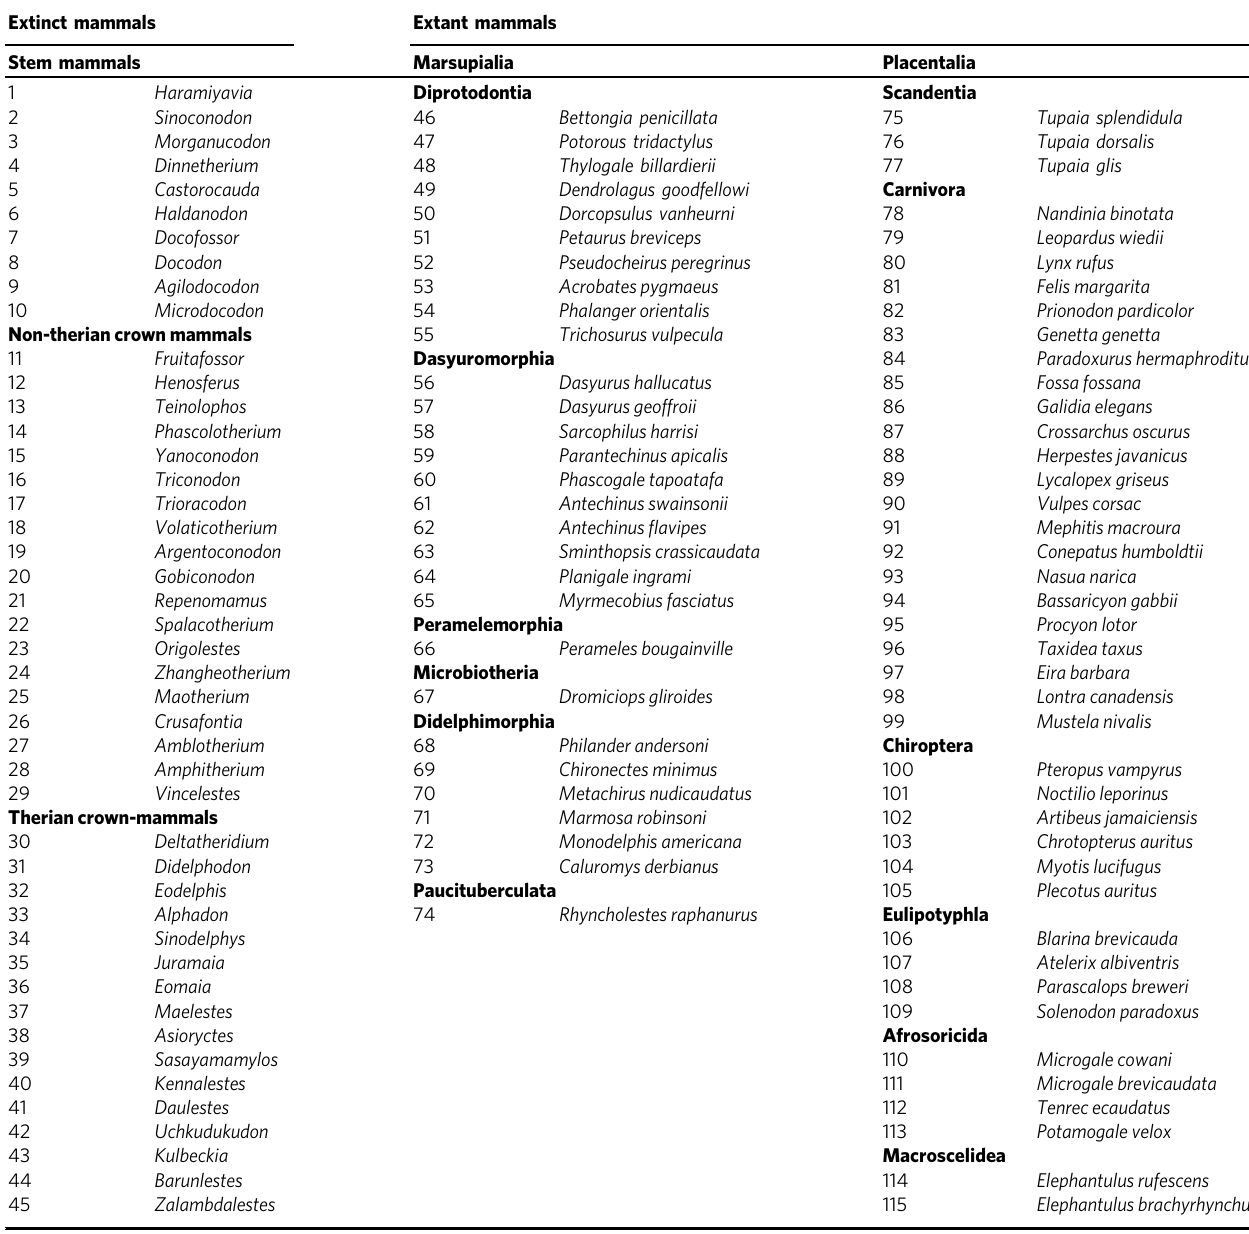
Table 1 Complete list of all the taxa used in this study. Extinct